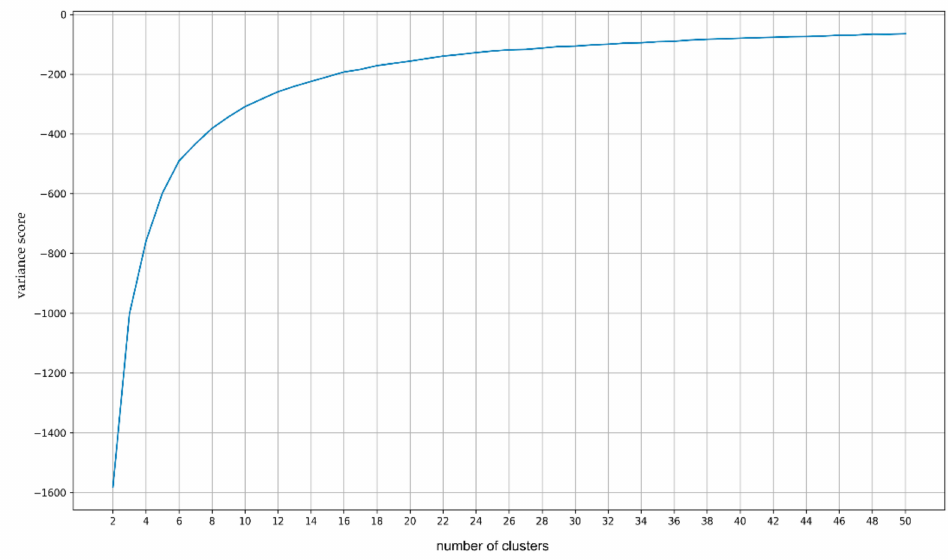
Figure 5. Estimation of variation by number of distributions using the elbow method.